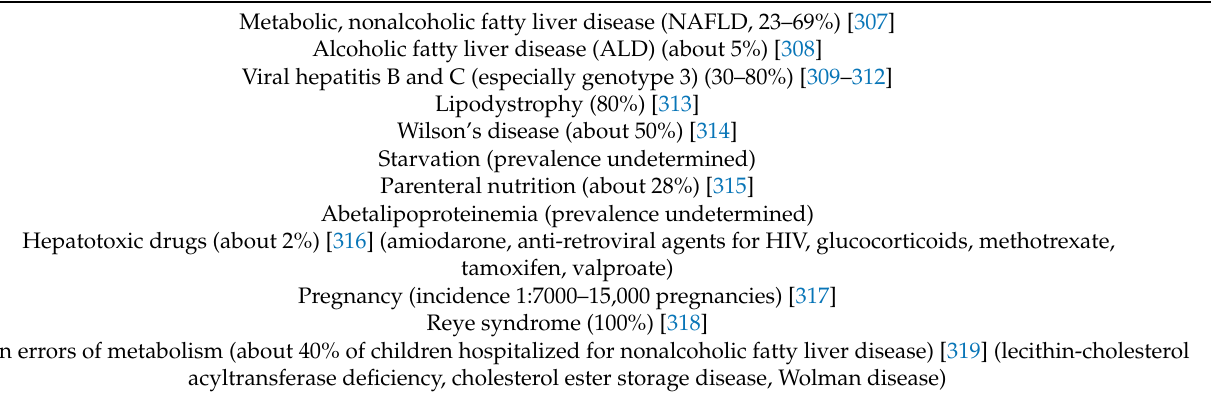
Table 2. Most frequent causes of liver steatosis and relative prevalence in each pathologic